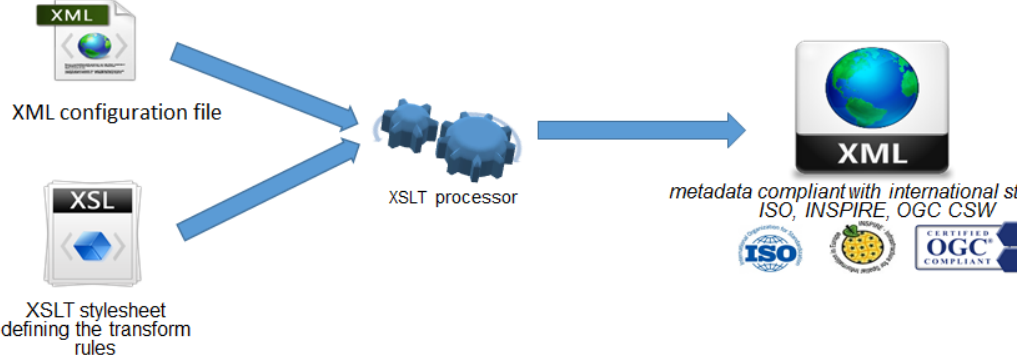
Figure 8. Metadata creation process, by means of the configuration file and an XSL